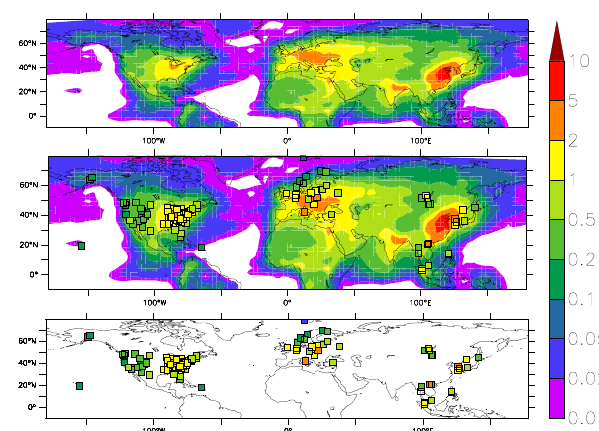
Fig. 10. Same as Fig. 9 but for ammonium aerosol (µg(NH 4 + )m − 3 ).